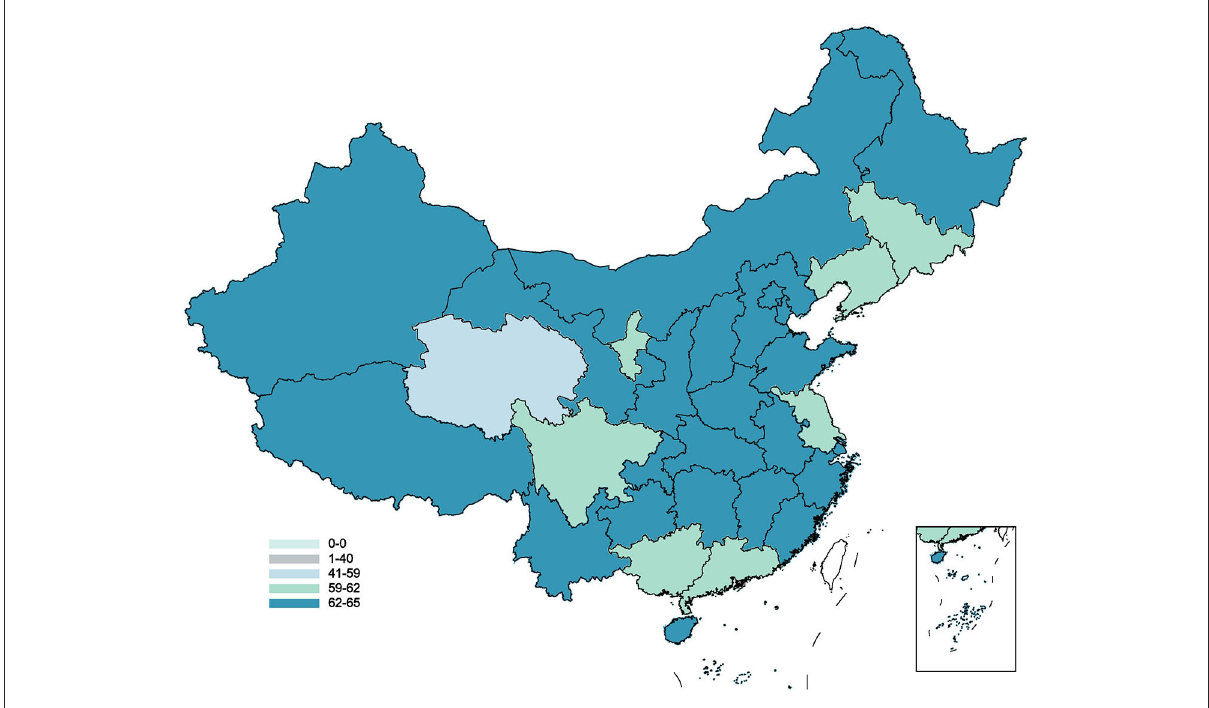
FIGURE1 The distribution of acceptance of hospice care in China.